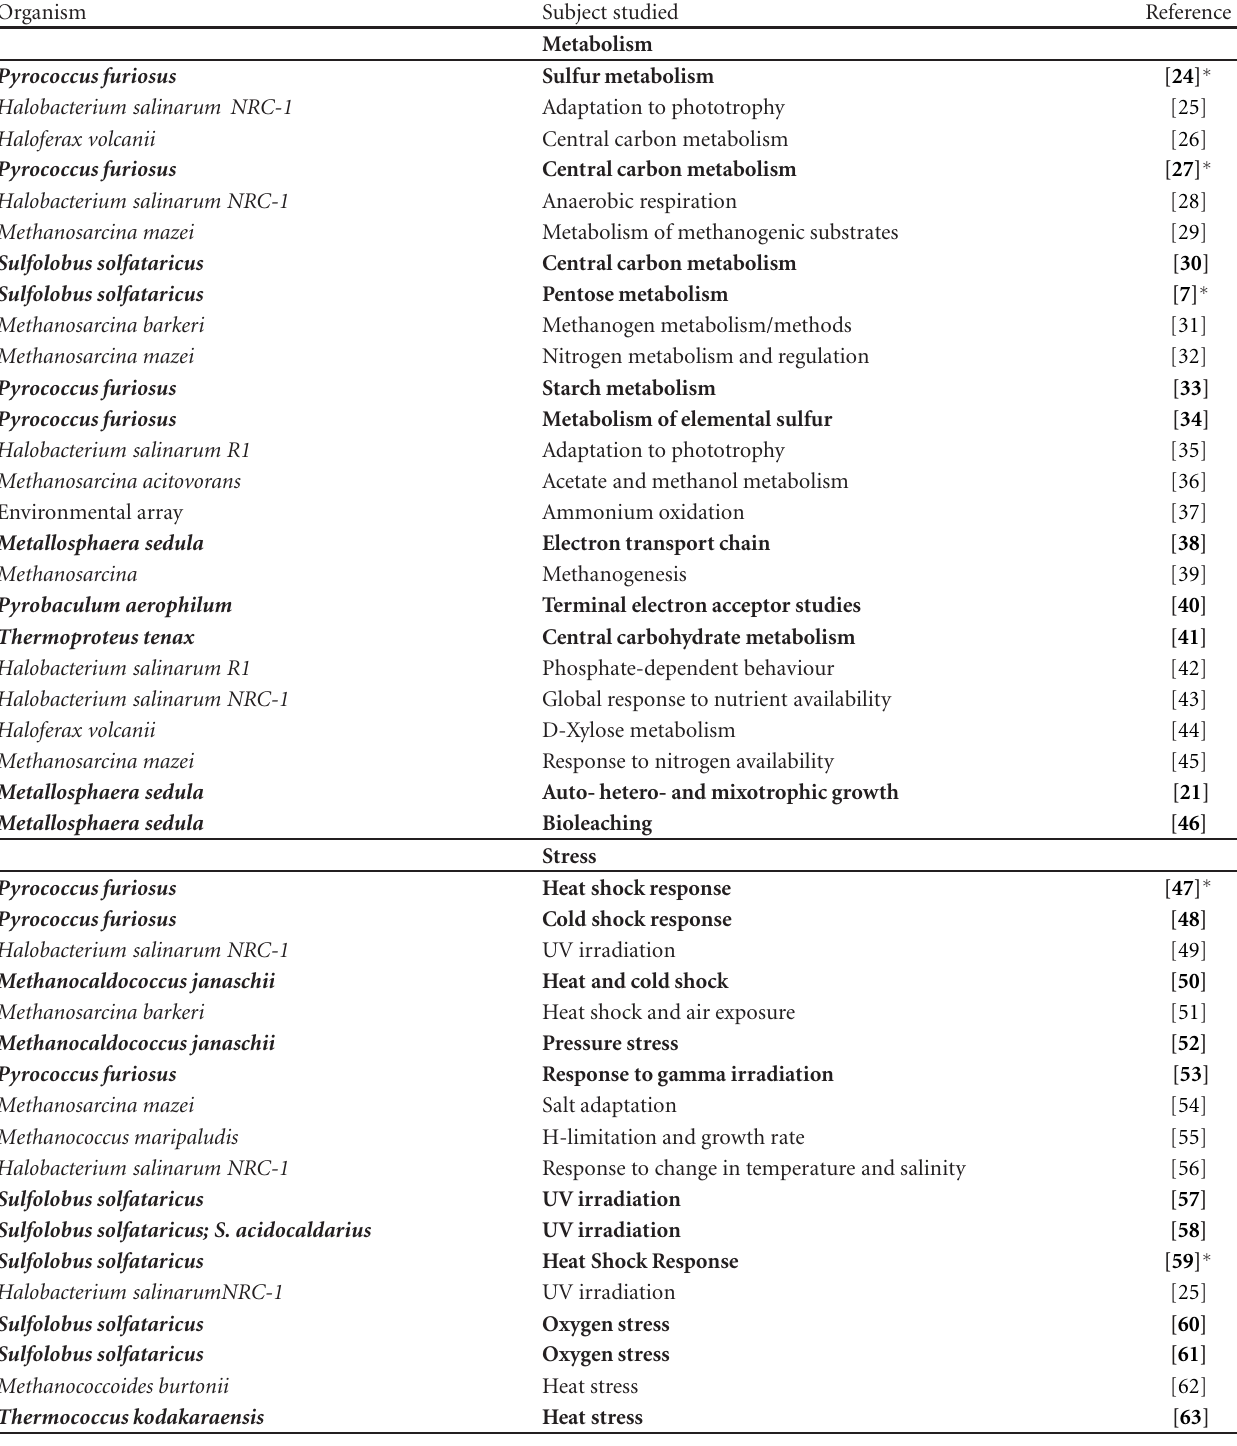
Table 1: A list of di ff erent archaeal transcriptome publications. This table shows that transcriptome studies are mostly done to elucidate metabolic processes or the behaviour of di ff erent archaea in stress situations. The publications are sorted by subject. Per subject the publications are sorted by year of publication. We included some environmental studies because they give a crucial insight in the ecological function of archaeal species. We excluded some of these publications because in our view they focused more on nonarchaeal species, which is a subject not related to this article. The studies referring to thermophiles are in bold. The studies more described in this paper in more detail are marked with an asterisk next to the